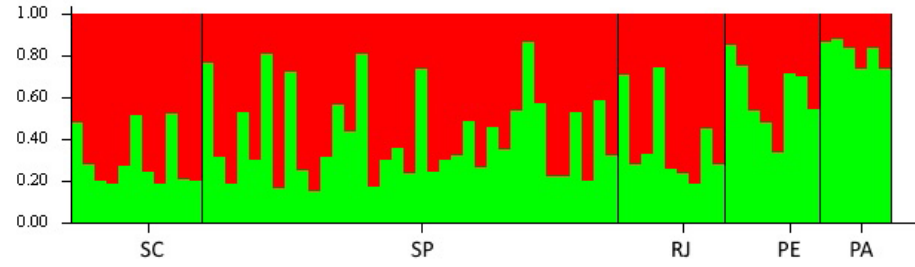
FIGURE 4 | Bayesian clustering evidenced by STRUCTURE with K = 2. A vertical bar represents each individual, and the length of each bar indicates the probability of membership in each cluster.